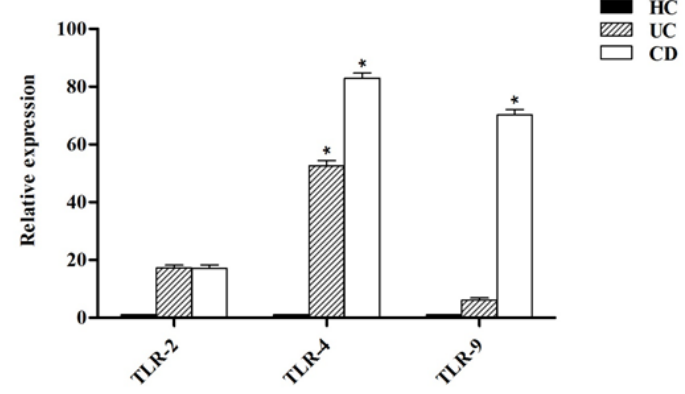
Figure 5. Relative expression of toll-like receptors (TLRs) in DCs from healthy controls (HC), ulcerative colitis (UC) and Crohn’s disease (CD) patients. * p < 0.05.